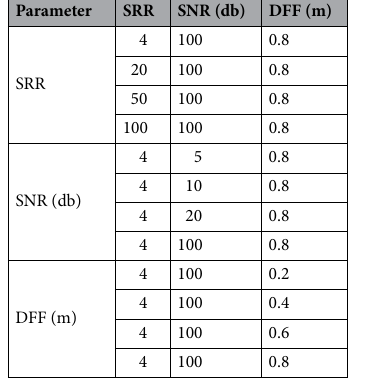
Table 1. Parameter settings.